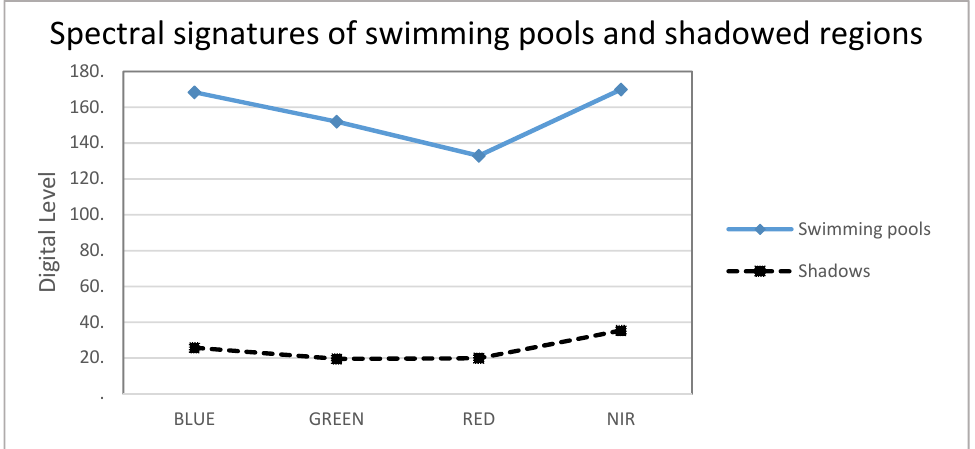
Figure 8. Spectral signatures of swimming pools and shadowed